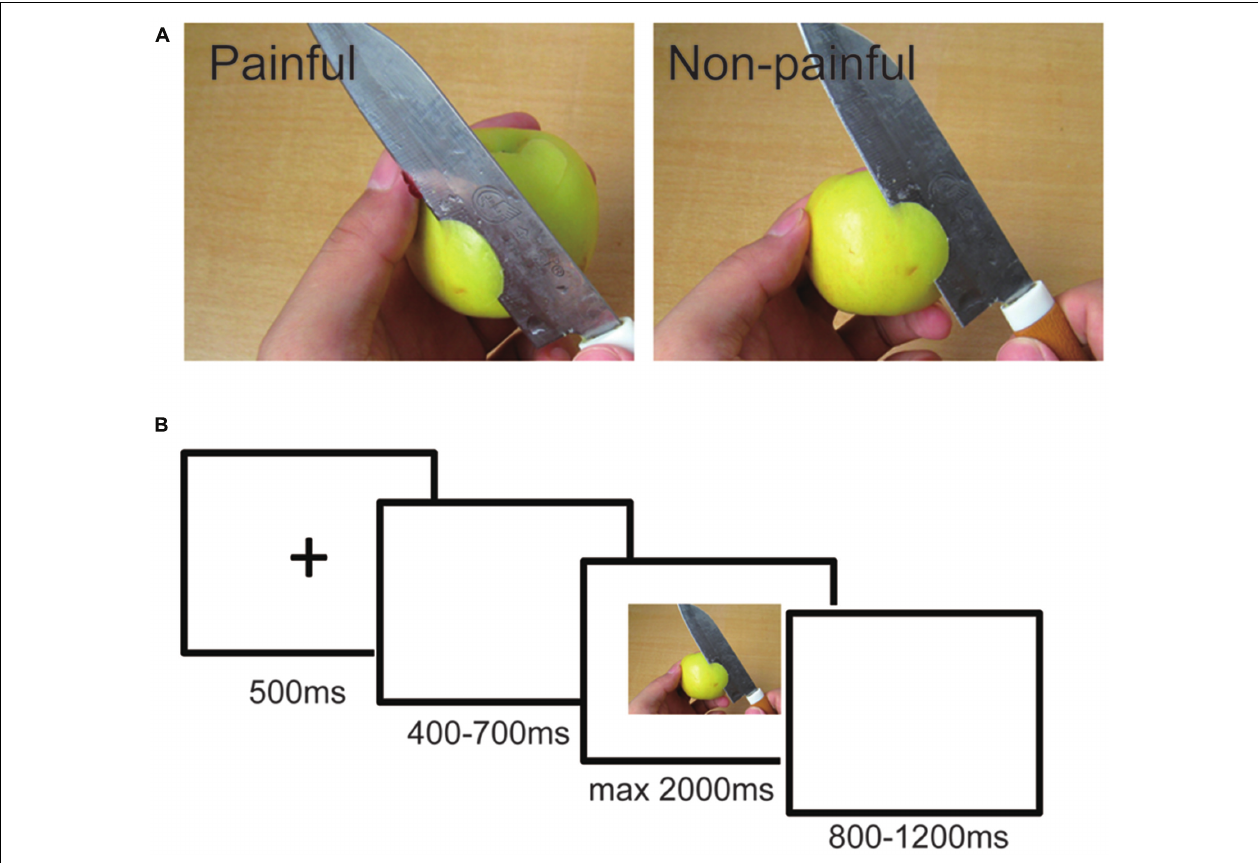
FIGURE 1 | (A) Examples of the pictures (Left panel: painful picture; Right panel: non-painful picture); (B) Structure of one trial. Each trial started with a 500 ms fixation, after a 400–700 ms random blank interval, the picture appeared for a maximum of 2000 ms and the participants were supposed to judge if the picture was a painful one or a non-painful one as soon and accurately as possible. The picture disappeared when a response was given. The ISI between trials was 800–1200 ms